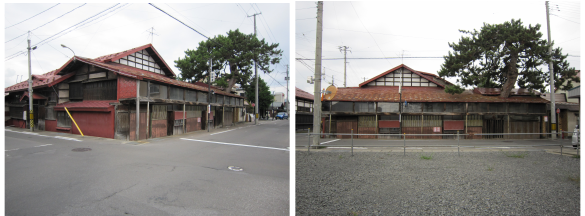
Figure 3. Pictures of the Former Matsuno-Yu building from local archive before the restoration in